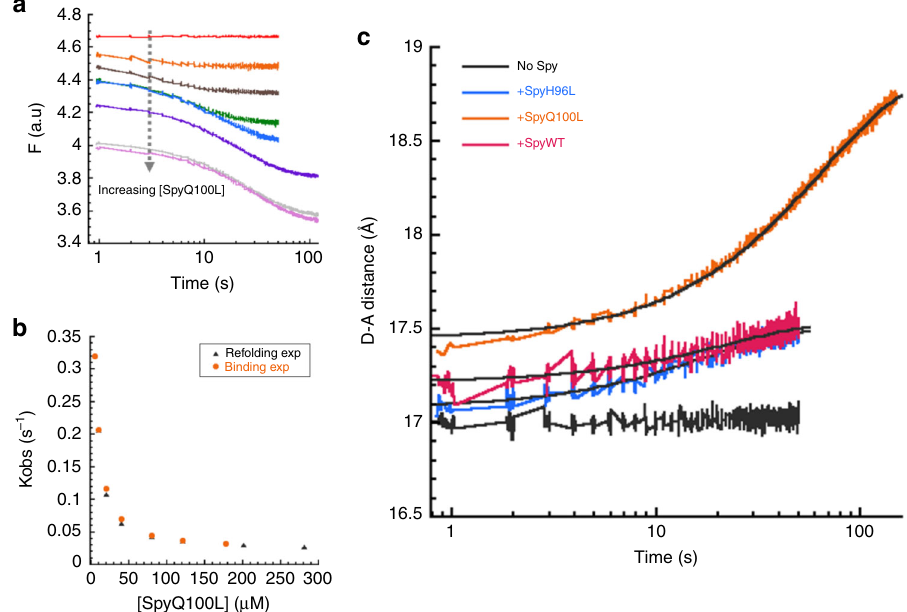
Fig. 5 The kinetics of SpyQ100L binding to native SH3. a Traces for SpyQ100L binding to native SH3. The fl uorescence change in the burst phase re fl ects the rapid binding of SpyQ100L to native SH3. An additional slow exponential decrease was observed after the initial binding of SpyQ100L to SH3, which is not observed with wild-type Spy binding to SH3 (Supplementary Fig. 2). b The k obs measured in the binding experiment (orange circles) was overlaid with the k obs determined from the SH3 refolding kinetics (black triangles) as a function of SpyQ100L concentrations. c The changes in the apparent D-A distance for native SH3 binding to Spy (160.7 µ M after mixing; pink), SpyH96L (160.7 µ M after mixing; blue) and SpyQ100L (80.3 µ M after mixing; orange). Native SH3 mixed with buffer shown in black. The fi nal apparent D-A distances for SH3 binding to Spy, SpyH96L and SpyQ100L were 17.54 ± 0.03 Å, 17.55 ± 0.03 Å and 18.87 ± 0.02 Å,